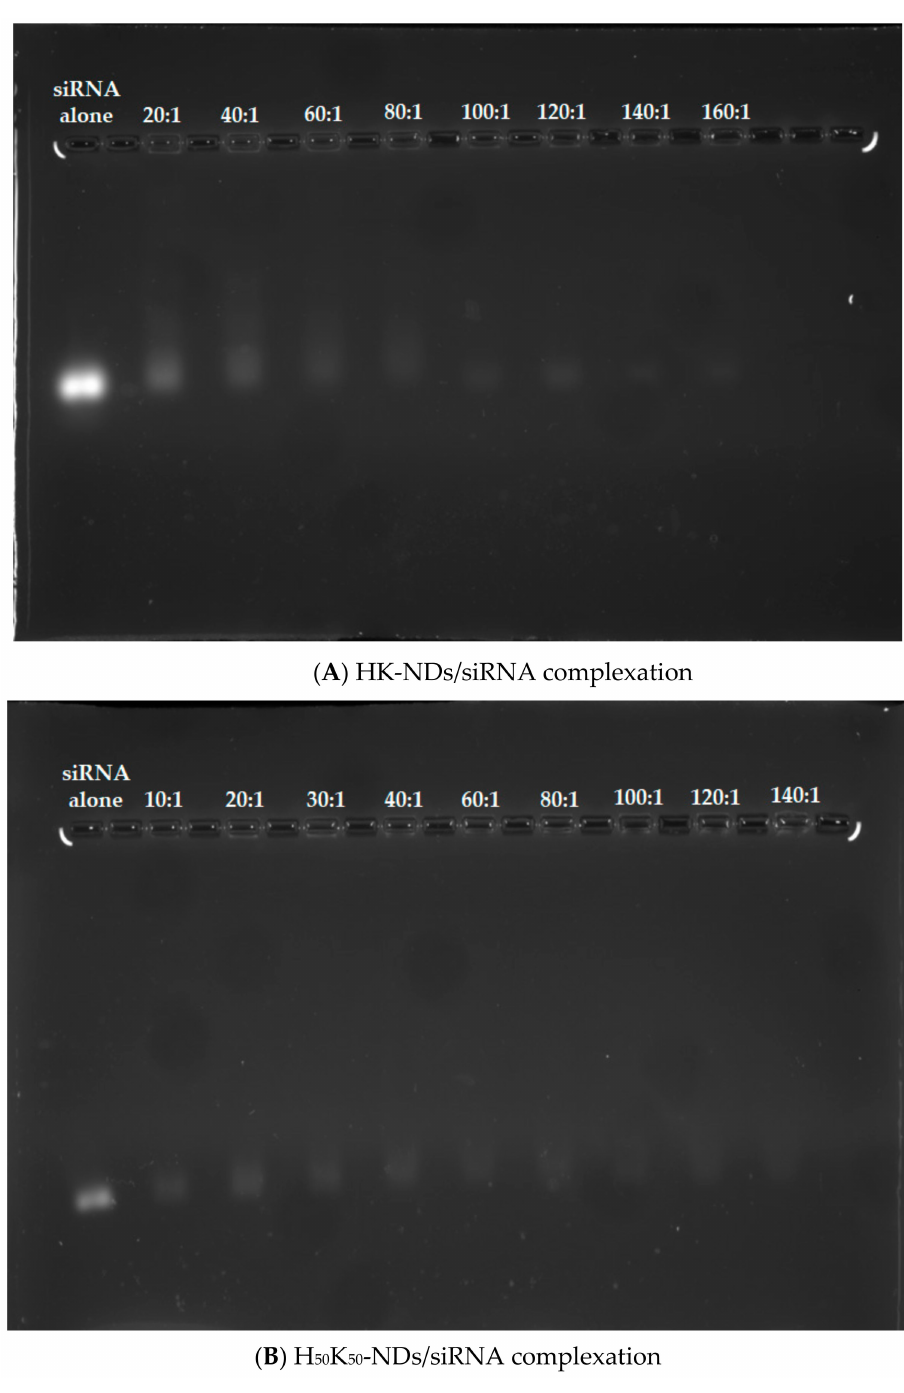
Figure 5. Binding of (A ) HK-NDs and ( B ) H 50 K 50 -NDs with siRNA. HK-NDs binds with siRNA at minimum mass ratio of 60:1 while H 50 K 50 -NDs significantly improves gene binding, reducing the minimum mass ratio to 30:1 (HK-NDs = lysyl-histidine-NDs; H 50 K 50 -NDs = lysine/lysyl-histidine- NDs; siRNA = small interfering ribonucleic